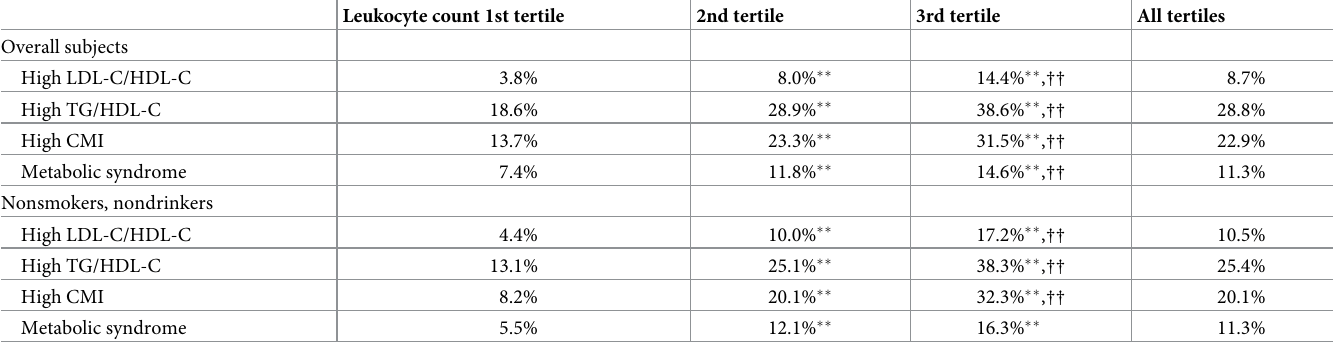
Table 5. Comparison of prevalences of each cardiometabolic risk factor in the tertile groups of leukocyte count in overall subjects and subjects without habits of smoking and alcohol drinking.